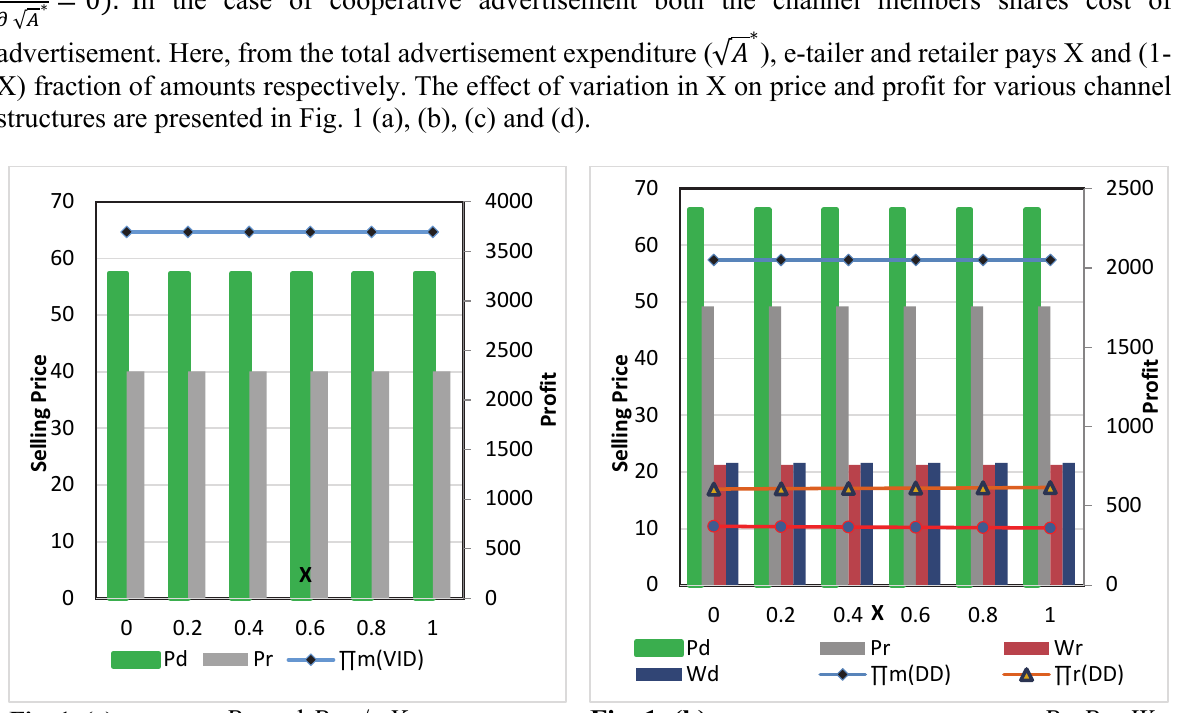
Fig. 1. (a) π r (VID-SC) , P r , and P d v/s X Fig. 1. (b) π m (DD-SC) , π r (DD-SC) , π d(DD-SC) , P r , P d , W r and W d v/s